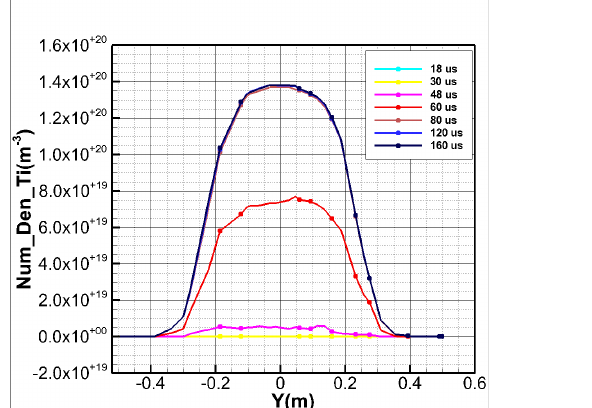
Figure 11. Variation curves of the atomic Ti and Ti 2+ number densities along the y-direction for a specific line.